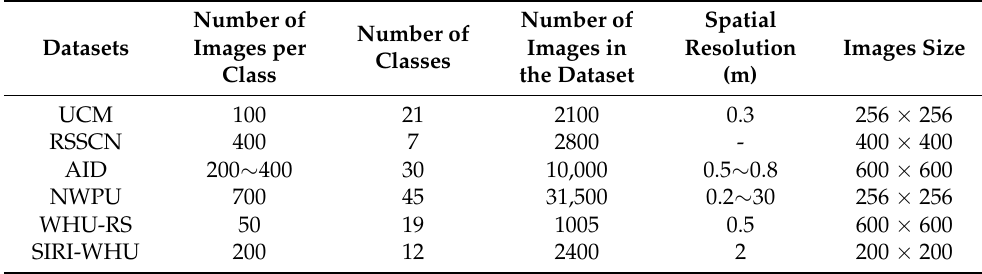
Table 4. Detailed introduction of six different